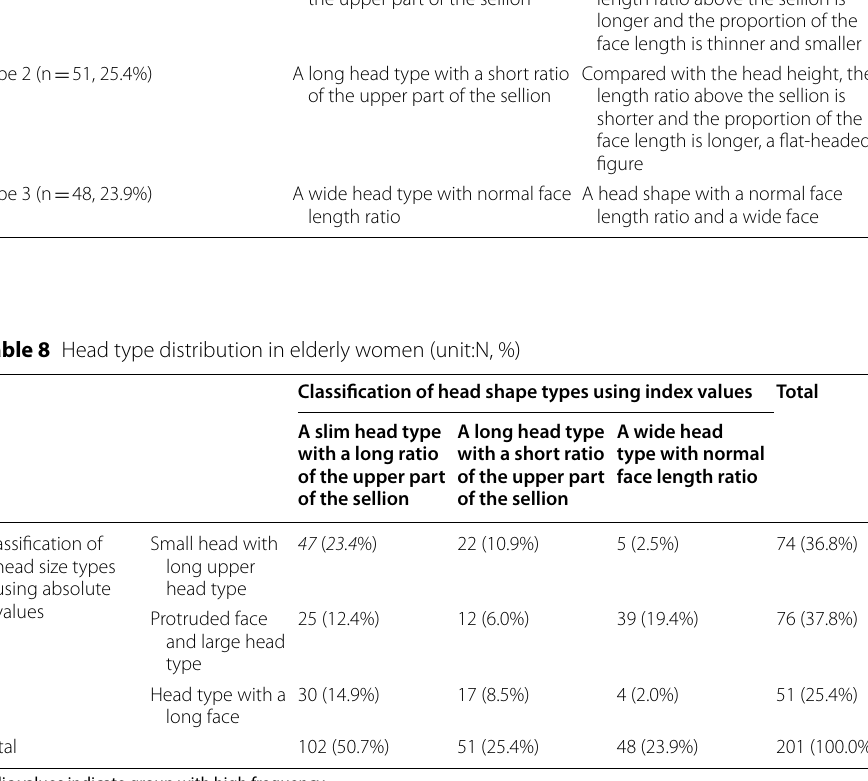
Table 7 Characteristics by head type by cluster classification of index values Head type Classification Characteristic Type 1 (n 102, 50.7%) =